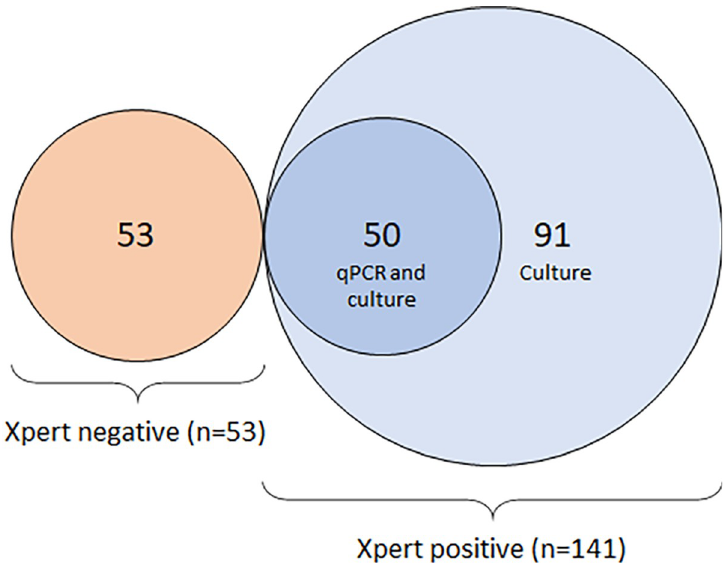
Fig 1. Patient numbers for oral swab study. Patients were enrolled in a nested strategy for MTB detection by qPCR (50 Xpert positive individuals and 53 Xpert negative individuals) or mycobacterial culture (141 Xpert positive individuals). All Xpert positive individuals from the qPCR arm were included in the culture